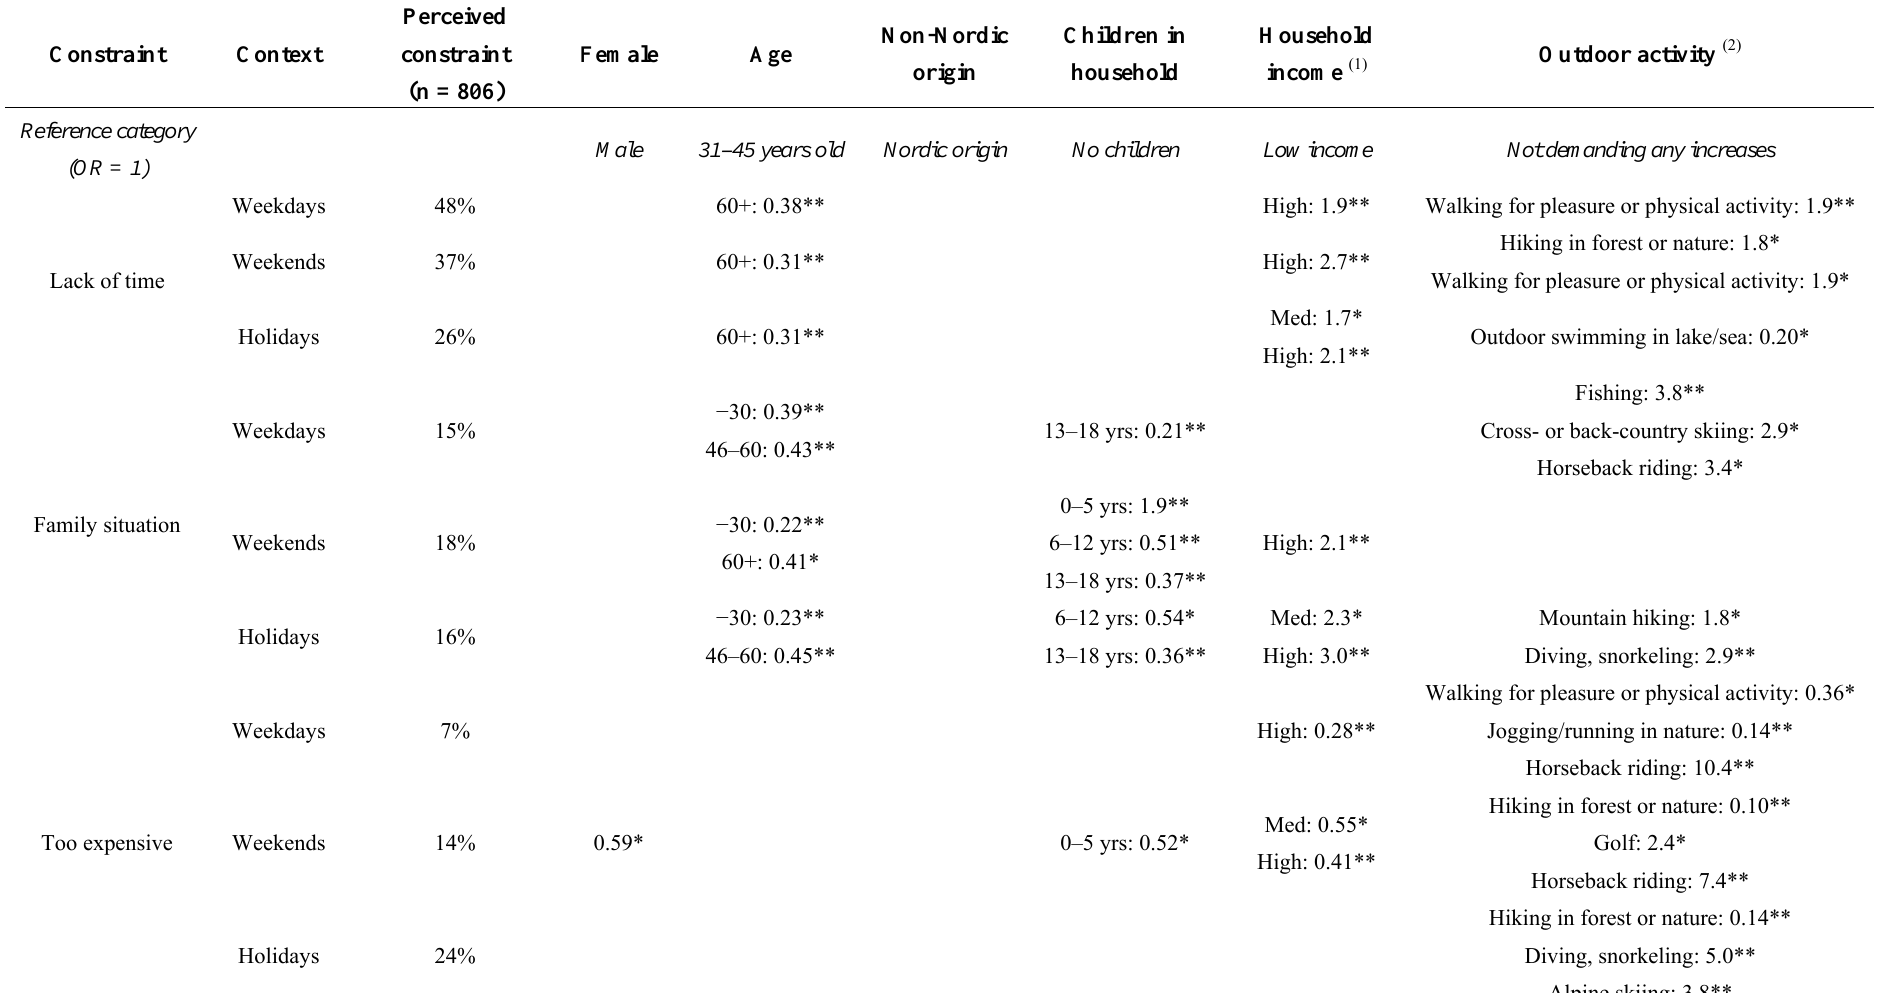
Table 2. Logistic regression analyses of constraints to increase participation in outdoor recreation activities. Significant (p < 0.05) odds ratios (OR) are shown in the